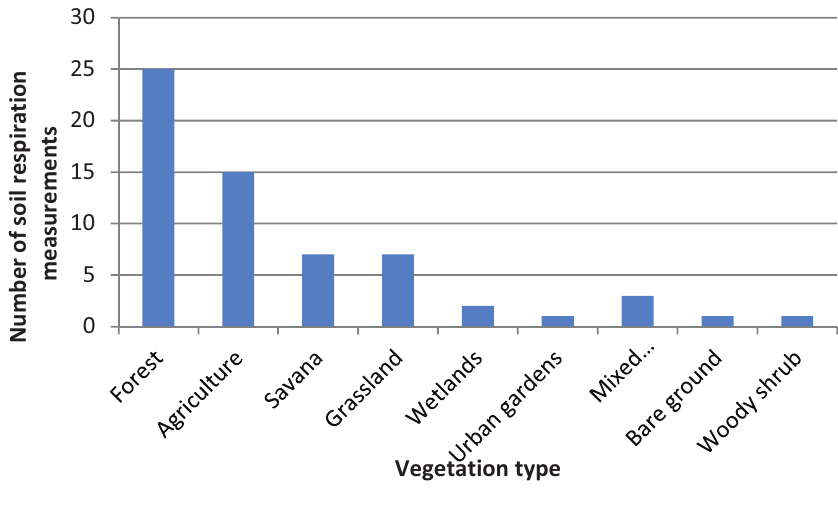
Figure 2. Main vegetation types and number of soil respiration